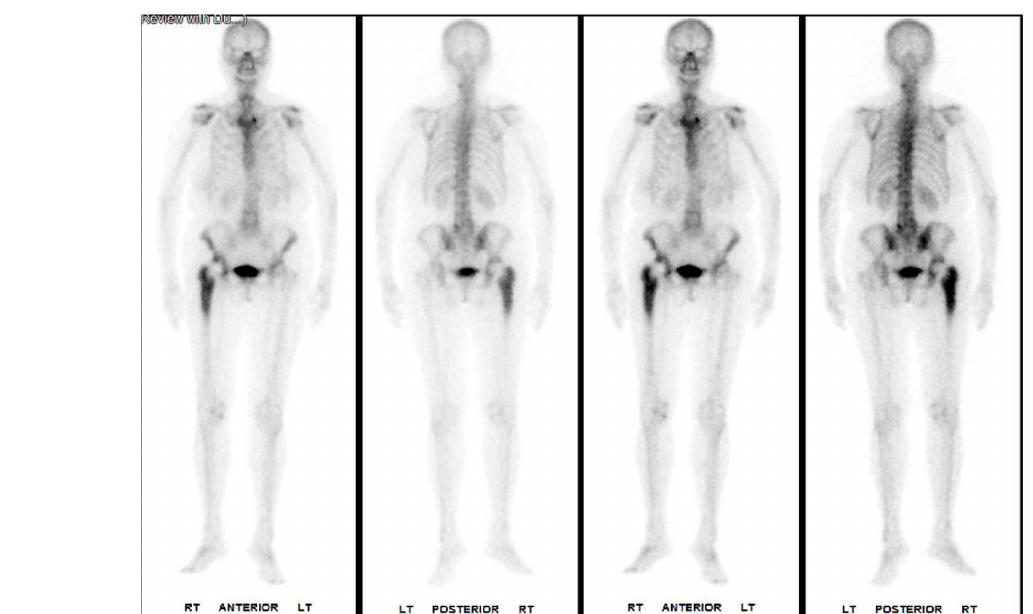
Figure 1. Single-photon emission computed tomography (SPECT) showing increased signal around the right hip and signs of chronic periosteal reaction around the